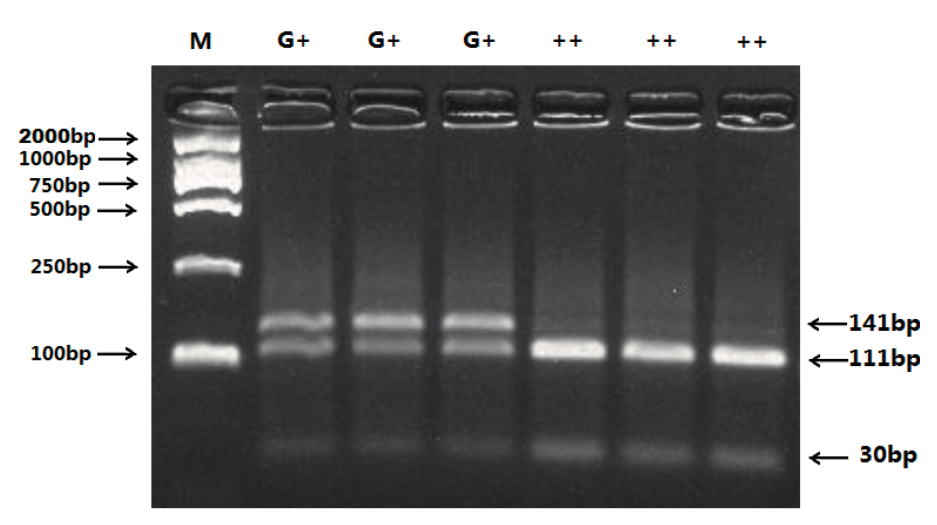
Figure 2. PCR-RFLP results of different genotypes of the PCR products digested by enzyme Hinf I c.718C>T of ovine BMP- 15polymorphisms. The genotypes are marked on the top of the lanes. M: DNA Marker